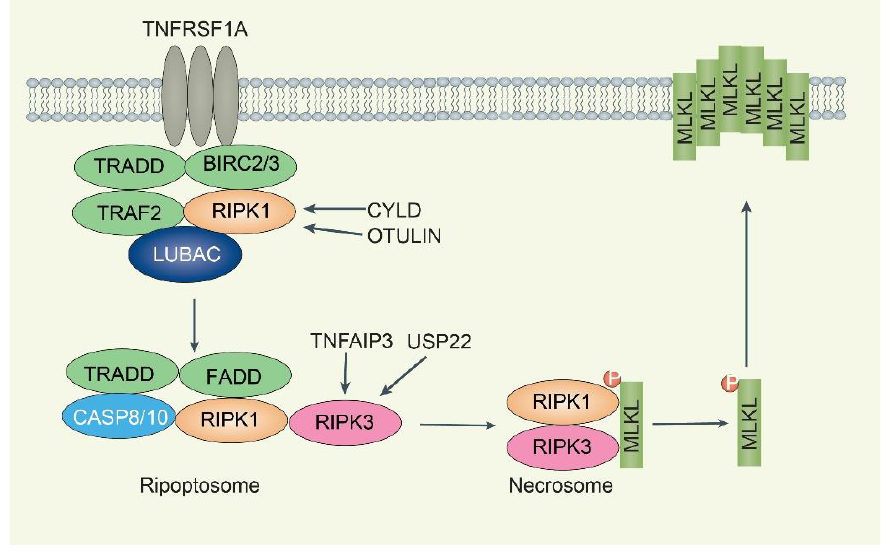
Figure 3. Overview of DUBs-mediated regulation of necroptosis. TNFRSF1A activates recruitment complex 1 (TRADD-TRAF2-RIPK1-BIRC2/3 complex), and RIPK1 is a core regulatory kinase regu- lated by ubiquitination. The DUBs CYLD and OTULIN stabilize RIPK1 for further ripoptosome for- mation (complex IIb). The ripoptosome complex has TRADD, FADD, CASP8/10, and RIPK1/3. If the activity of CASP8/10 is inhibited, RIPK1/3 and MLKL form necrosomes in which MLKL is phos- phorylated by RIPK3. Translocation of active MLKL to the plasma membrane results in membrane rupture. USP22 and TNFAIP3 reduce RIPK3 K518 and K5 ubiquitination, respectively. TNFAIP3 inhibits necroptosis, whereas USP22 accelerates necroptosis.